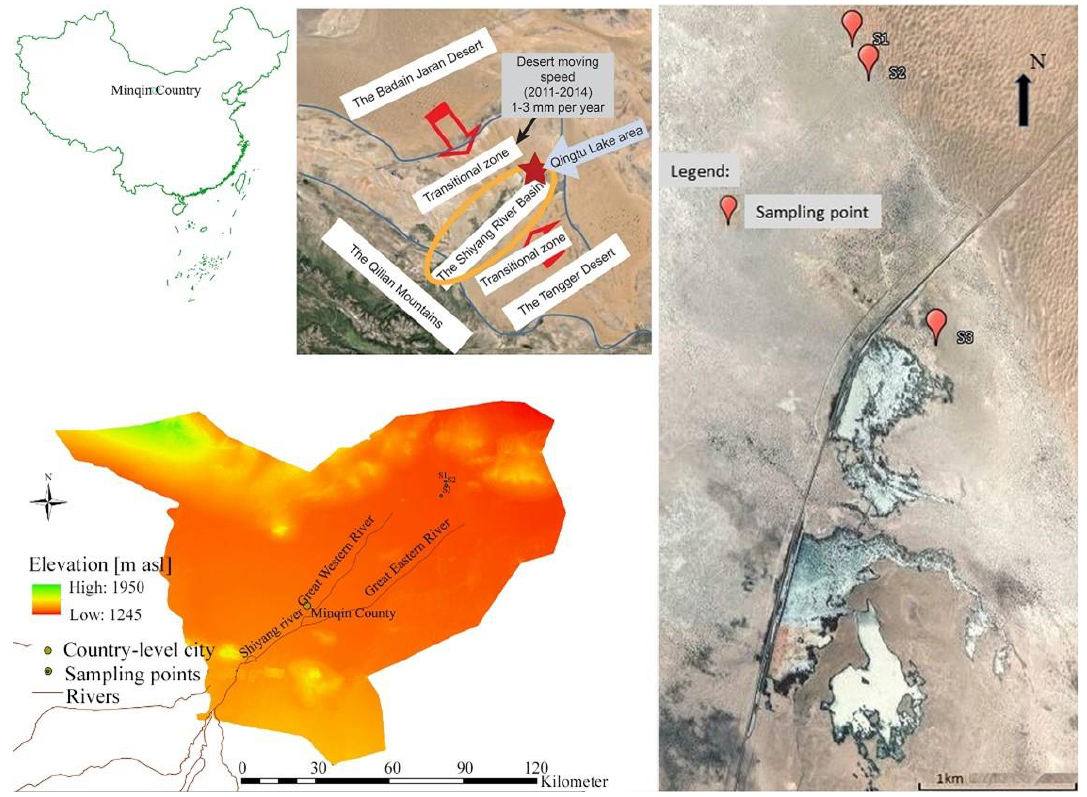
Figure 1. Digital elevation model and river network of Minqin County and the relative geographical location of Qingtu Lake (i.e., the study area, five-pointed star) as well as sampling locations (sub-circulars).